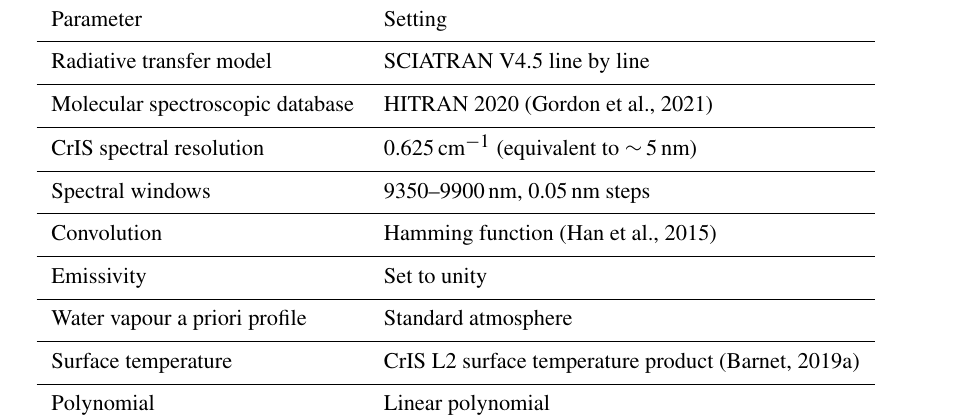
Table 3. RTM and pre-processing step settings in the